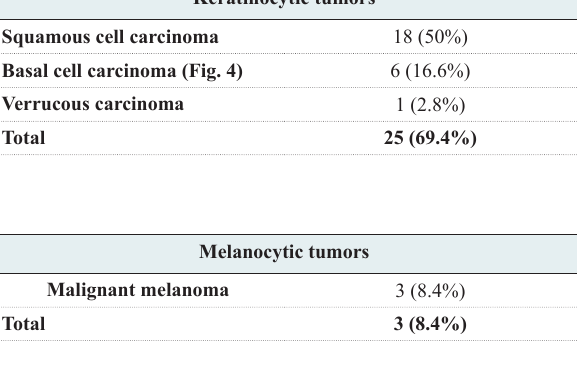
Table 4: Distribution of benign skin neoplasms in various age groups